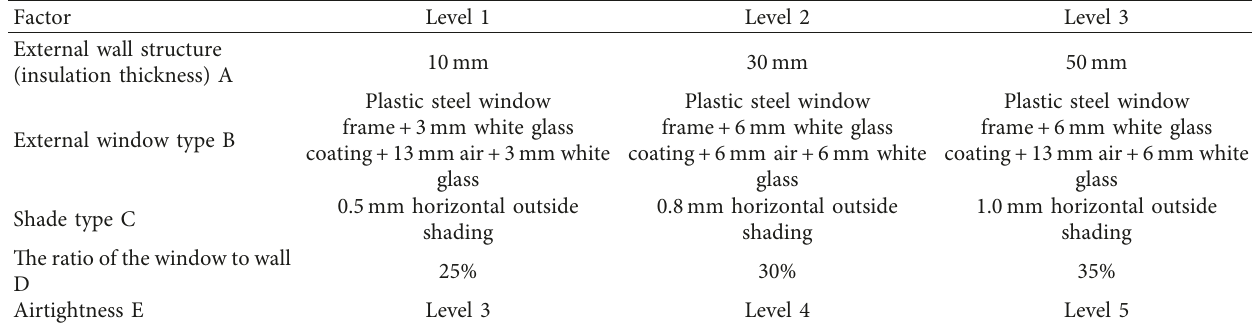
Table 7: Orthogonal test factor level table.